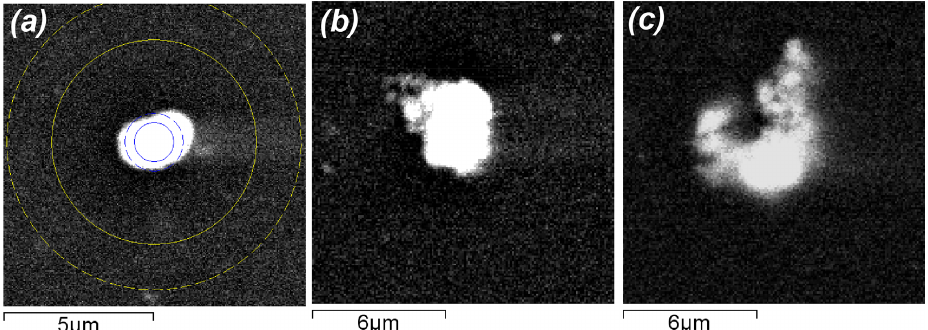
Figure 2. Scanning electron microscopic images in backscattered electrons of various types of vanadium-bearing (a, b, c) minerals located in a carbon (shungite) matrix of Sh1 samples. Panels (a) , (b) and (c) show representative Type I, Type II and Type III grains, respectively. The circles in Fig. 2a correspond to the minimum and maximum regions of electron scattering and excitation of characteristic X-ray radiation. That is, all the spectra shown in Table 2 contain a contribution from the carbon matrix and micro-sized inclusions, are semi-quantitative, and are given to assess changes in the compositions of vanadium-bearing minerals of various types. Table 2. EDS composition (in atomic %) of various types of vanadium-bearing minerals in shungite. Chemical Vanadium-bearing minerals element a Type I Type II Type III V carbide Eroded V carbide V carbide and (presumably) roscoelite